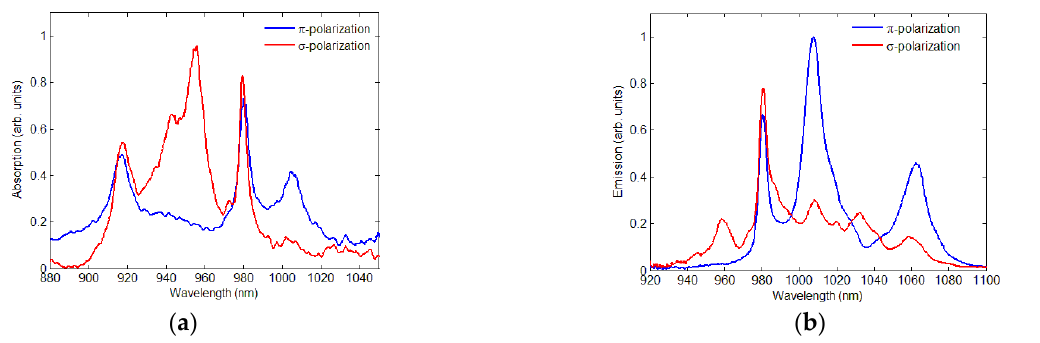
Figure 8. Polarization-dependent absorption ( a ) and fluorescence ( b ) spectrum of a 10 µ m wide and 2.2 cm long Yb:Ti:LiNbO 3 ridge